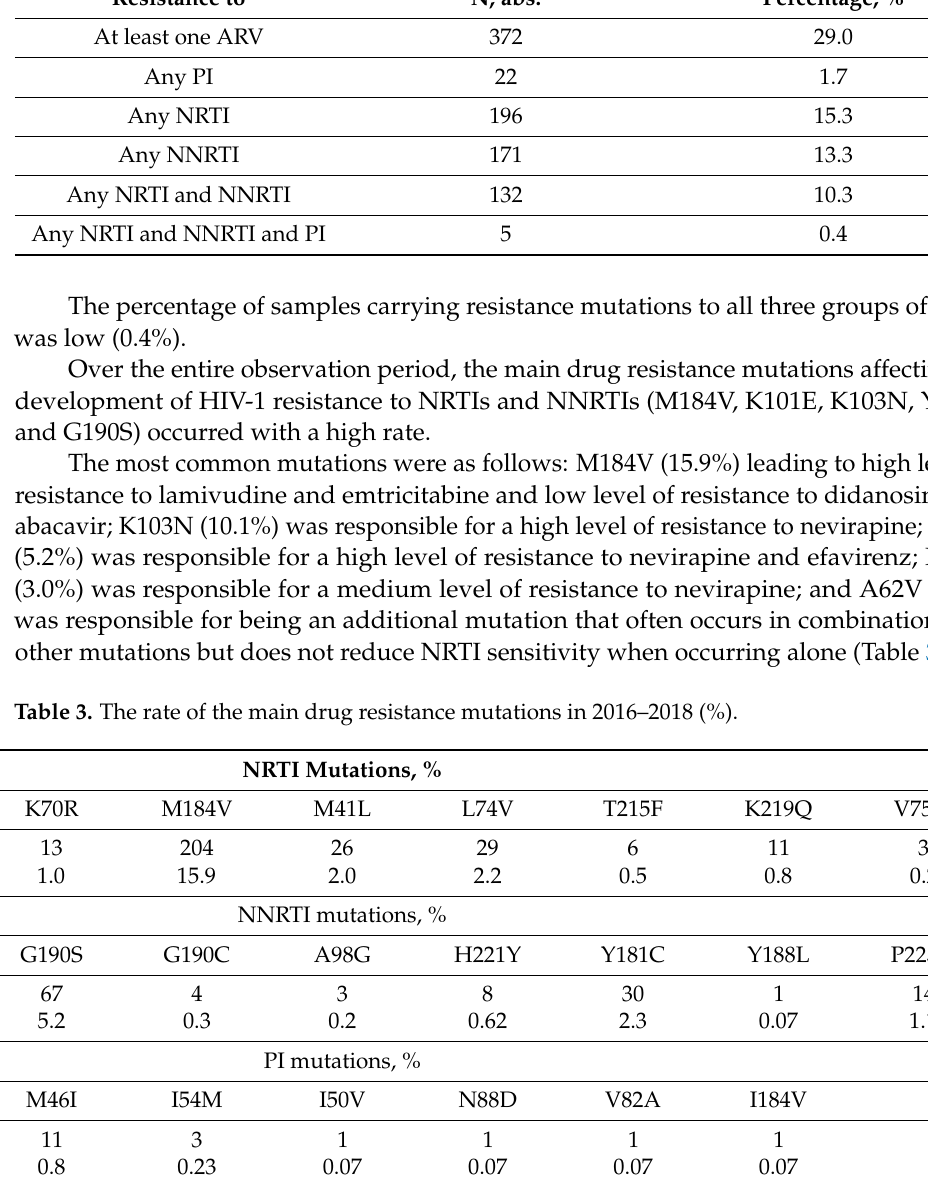
Table 2. Samples of HIV-1 with resistance mutations in the Siberian Federal District in 2016–2018, absolute number, and %. Resistance to N, abs.